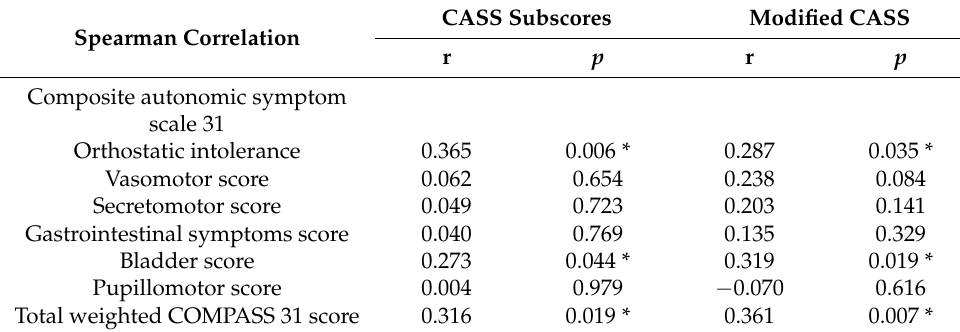
Table 3. Correlation analysis between parameters of COMPASS-31 and CASS subscores and Modified CASS.